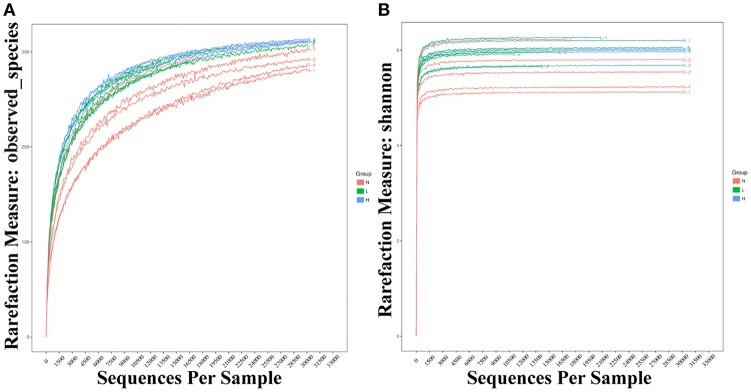
Rarefaction curves of observed species and Shannon-Wiener diversity for all samples. (A) Rarefaction curves of observed species from fecal samples of individual mice fed with a normal diet (red), low-capsaicin diet (green), or high-capsaicin diet (blue). (B) Rarefaction curves of Shannon-Wiener diversity from fecal samples of individual mice fed with a normal diet (red), low-capsaicin diet (green), or high-capsaicin diet (blue).